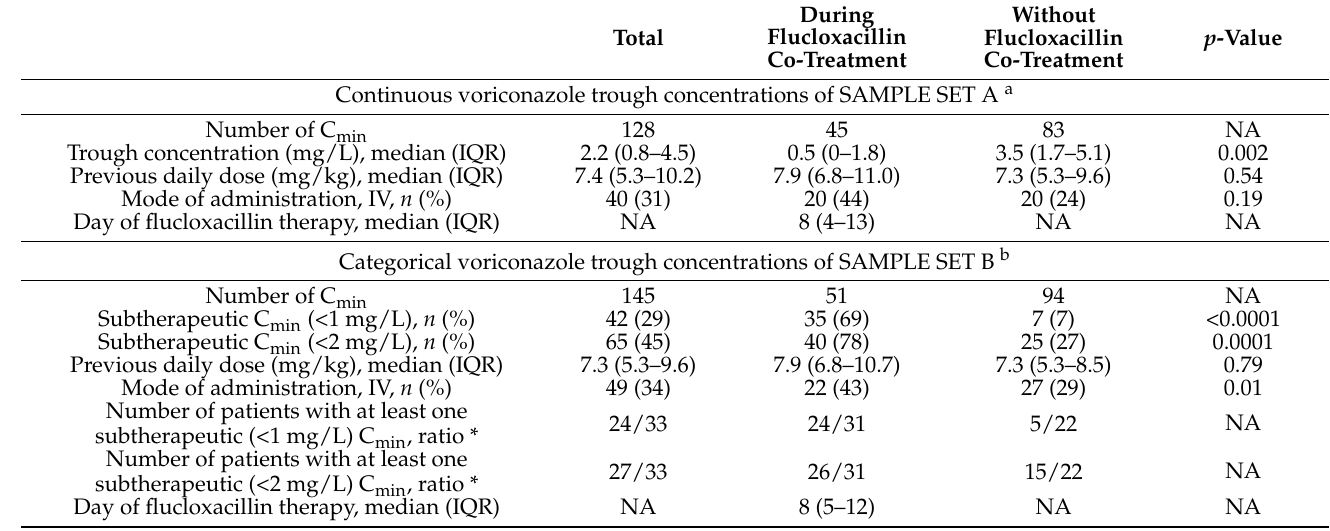
Table 1. Voriconazole trough concentrations.